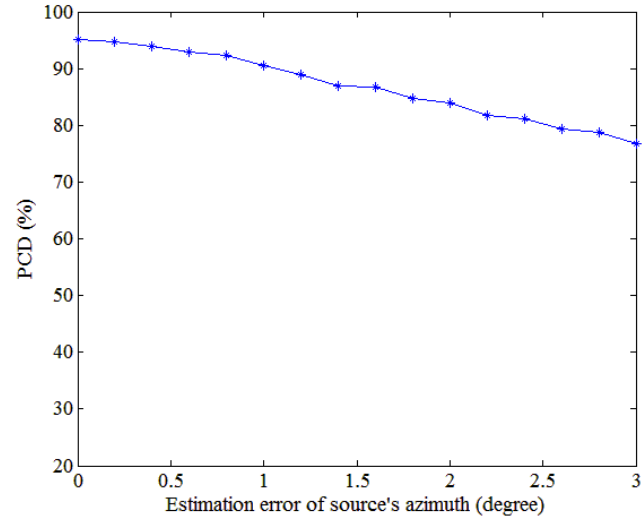
Figure 11. Performance evolution with the azimuth estimation error. The source azimuth estimation ranges from 0 to 3 degrees.